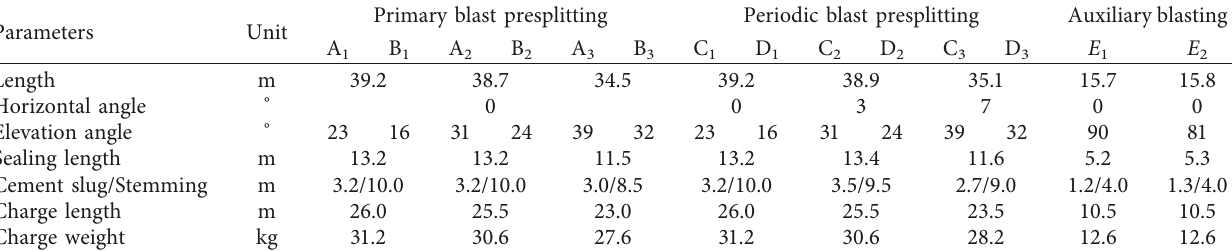
Table 8: Technical parameters of presplitting blast